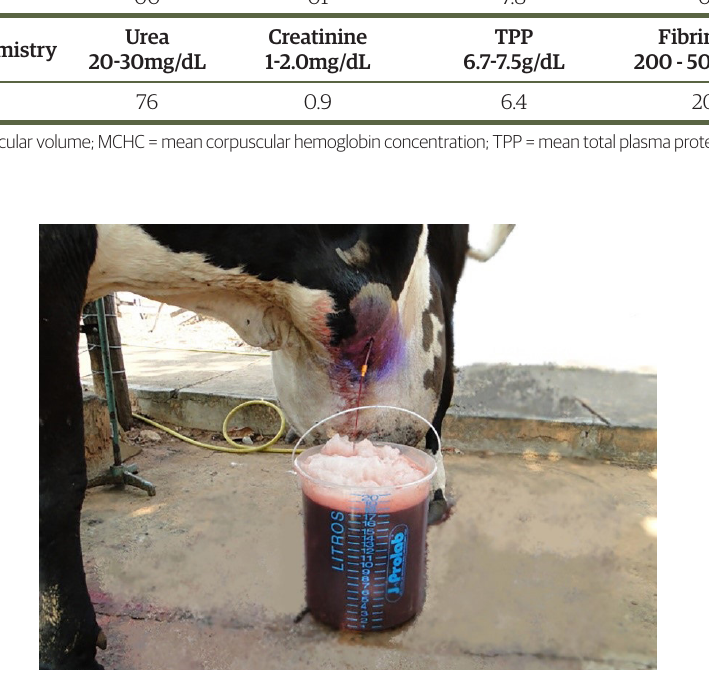
Figure 3. Serosanguineous transudate after drainage of the region around the mammary